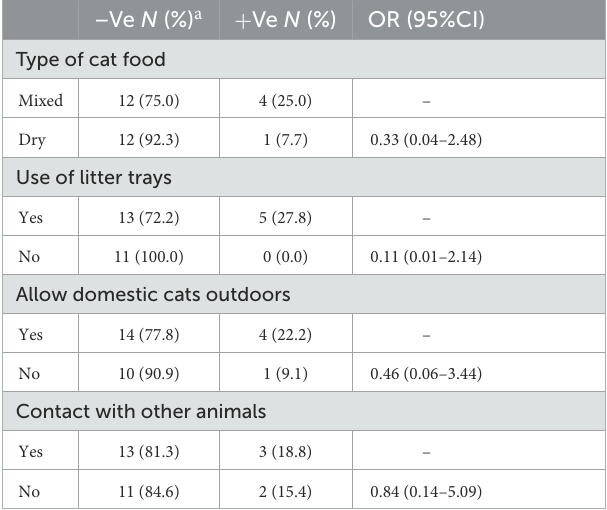
TABLE 3 A summary of risk factors of pet cats ( n = 29), univariable firth logistic regression